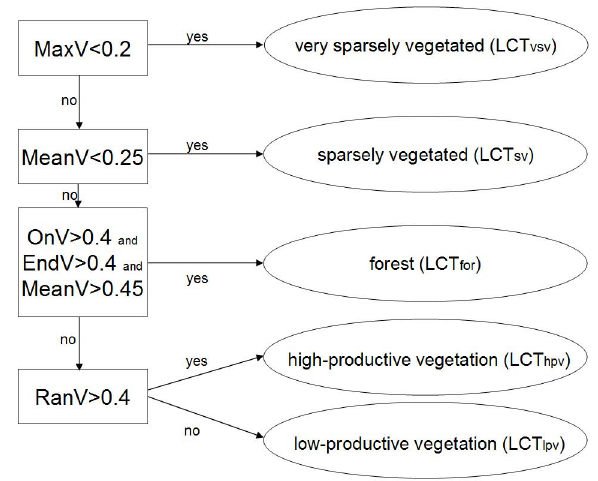
Fig. 3. Derived phenologic metrics according to Reed et al. (1994): MaxV (maximum NDVI value within the vegetation period), MeanV (mean NDVI value of the vegetation period), OnV (NDVI value at the beginning of the vegetation period), EndV (NDVI value at the end of the vegetation period), RanV (range between maxi- mum value within the vegetation period and minimum of OnV and EndV).